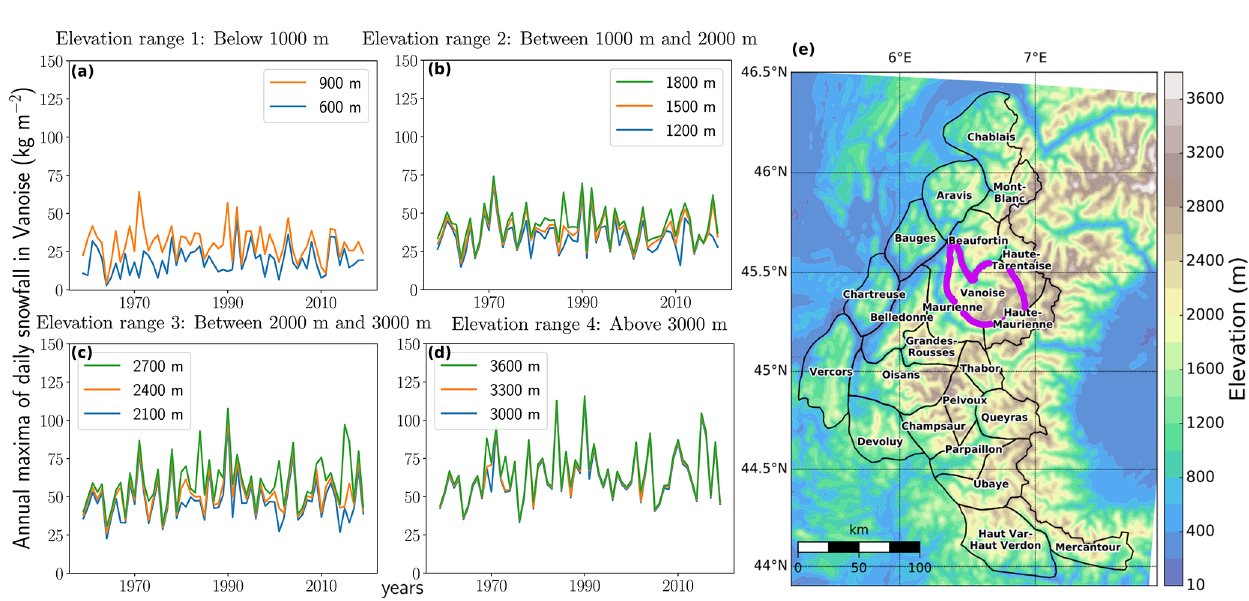
Figure 1. (a–d) Time series of annual maxima of daily snowfall from 1959 to 2019 for the Vanoise massif (purple region in e ) clustered by the four ranges of elevations considered. (e) Topography and delineation of the 23 massifs of the French Alps (Durand et al., 2009).